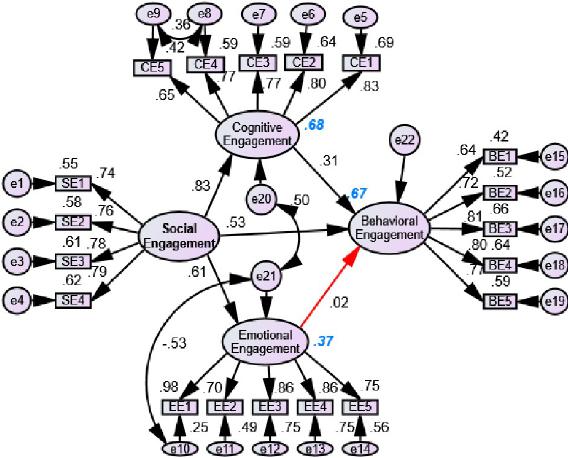
Fig 4. Effect of social, emotional and cognitive engagement on behavioral engagement (Model 1: Red arrow represents insignificant and black arrow represents significant results).